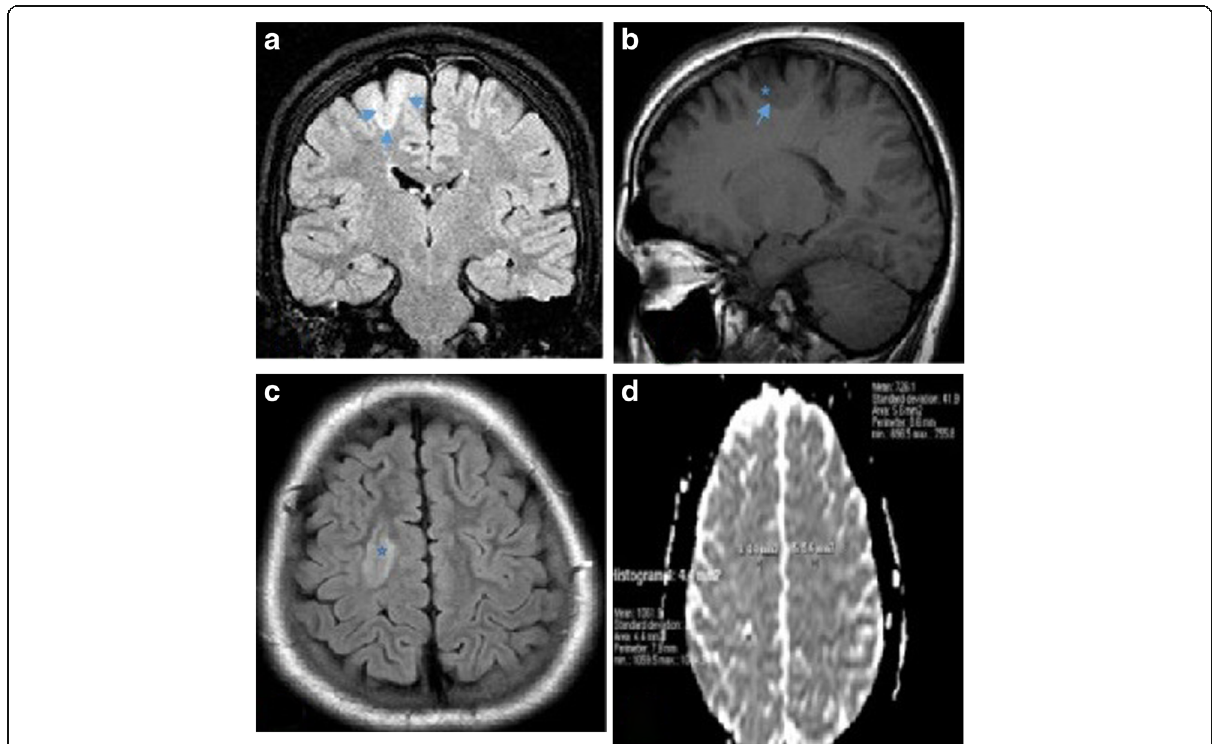
Fig. 4 A 13-year-old male patient with epilepsy. a Subcortical hyperintense in coronal FLAIR sequence. b Cortical thickening in sagittal T1A sequence. c Increase in cortical signal intensity in axial FLAIR sequence. d Hyperintense area in axial dADC sequence, ADC measurement from this area and from a symmetrical